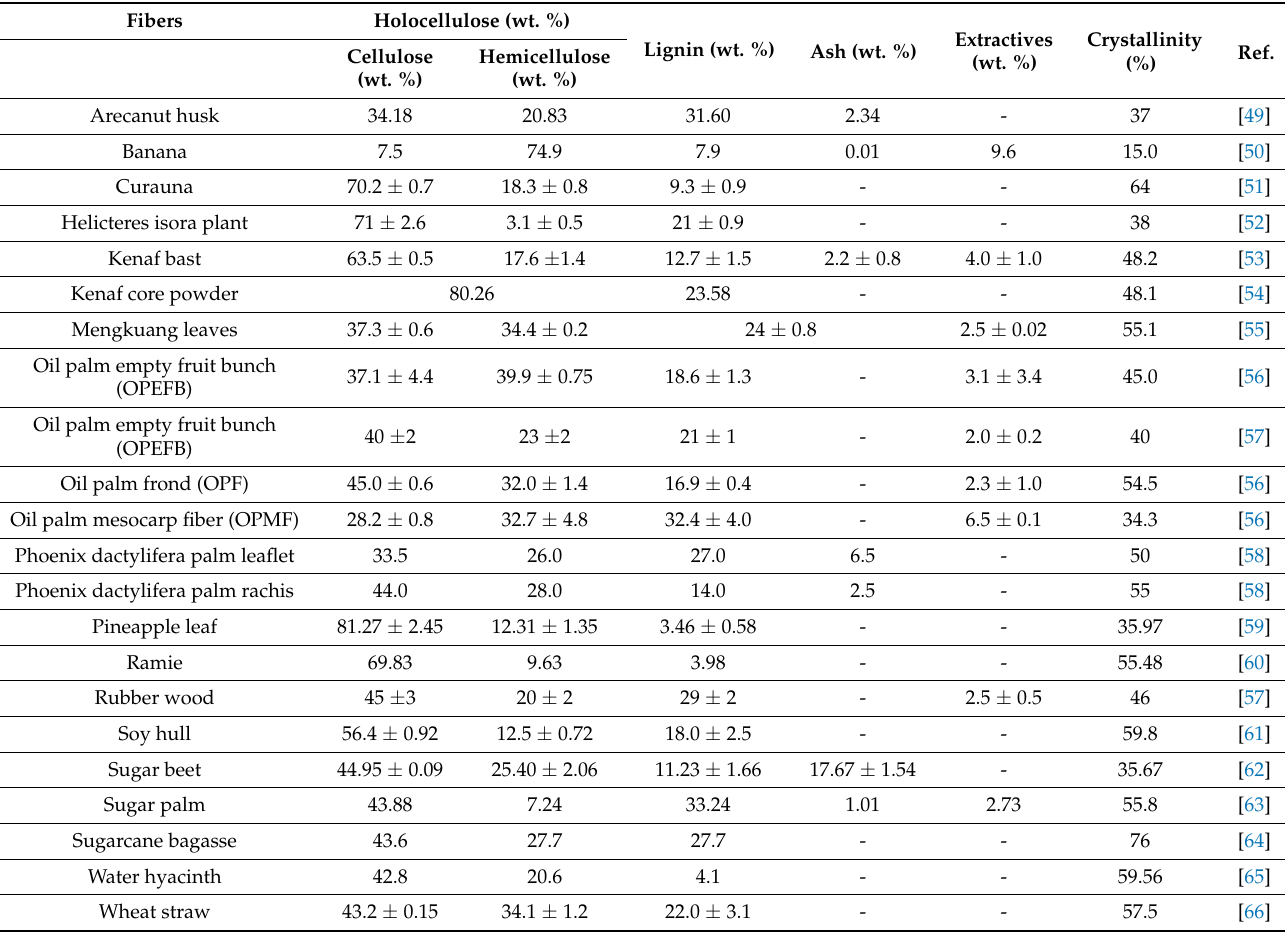
Table 3. Chemical composition of selected common natural